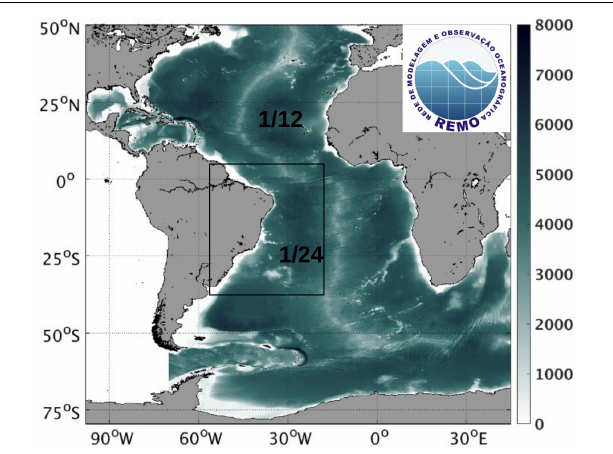
FIGURE 2 | REMO models nesting configuration, operational at the CHM, showing the depth (m) of the Atlantic basin domain (HYCOM grid with 1/12 o horizontal resolution), and the METAREA V domain (HYCOM grid with 1/24 o horizontal